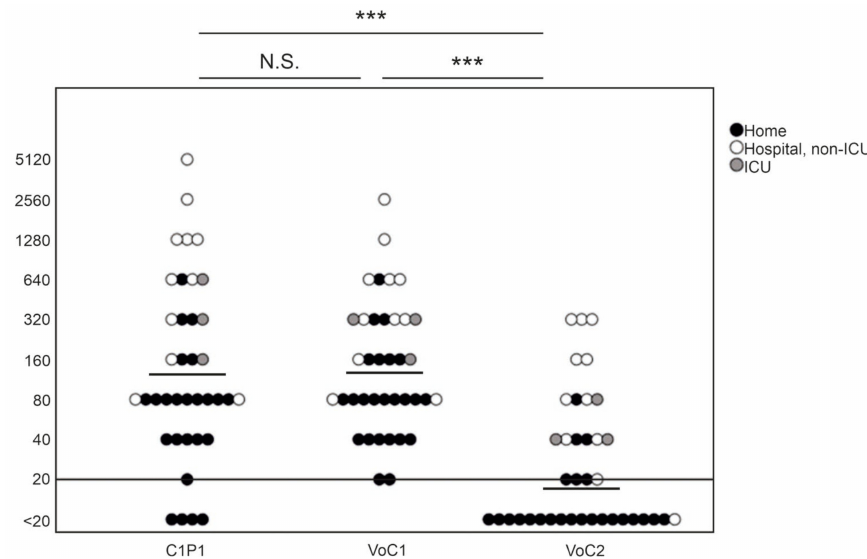
Figure 1. Comparison of neutralizing antibody titers with geometric mean lines against different SARS-CoV-2 strains. Comparison of C1P1, VoC1, and VoC2 titers with individual data points indicated in the picture. Titers are expressed in logarithmic scale (Log 2 ) and LOD has been marked with a horizontal line. Statistical significances are indicated with *** ( p < 0.001) and N.S. ( p > 0.05).